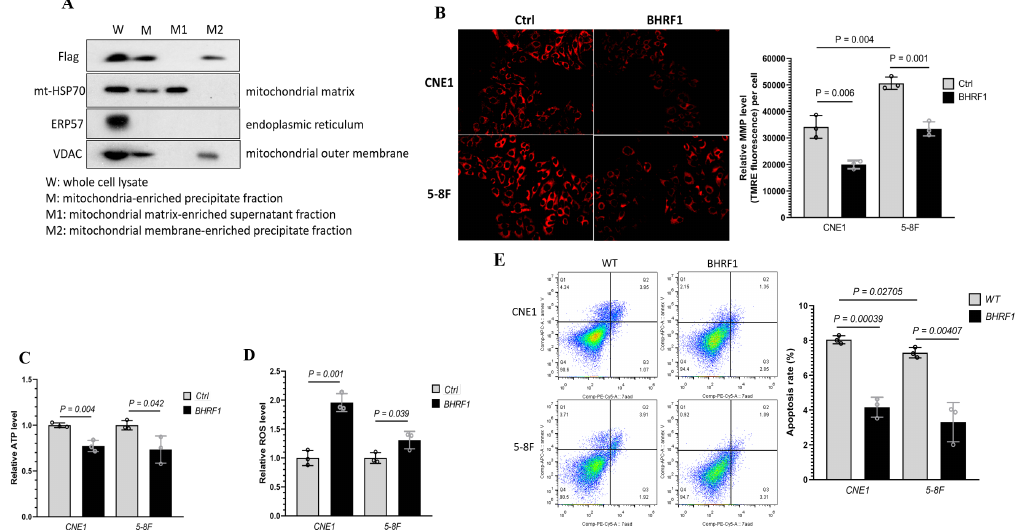
Figure 4. Mitochondrial localization of BHRF1 protein and the implications of BHRF1 on mitochondria function. ( A ), Western blots were used to detect BHRF1, VADC, ERP57 and mt-HSP70 proteins using specific antibodies for each protein, with the exception of BHRF1, which was detected with an anti-Flag antibody. ( B ), MMP was determined with TMRM fluorescence in BHRF1 high expression cells and control one. ( C ), Total ATP content was determined in BHRF1 high expression NPC cells and control ones ( n = 3). ( D ), Mitochondrial ROS levels were determined in BHRF1 high expression NPC cells and control ones ( n = 3). The levels of ATP and ROS were normalized via protein concentration. ( E ), Cell apoptosis rate was measured by FCM (flow cytometry). Representative images are shown and quantitation represents mean ± SE of three independent